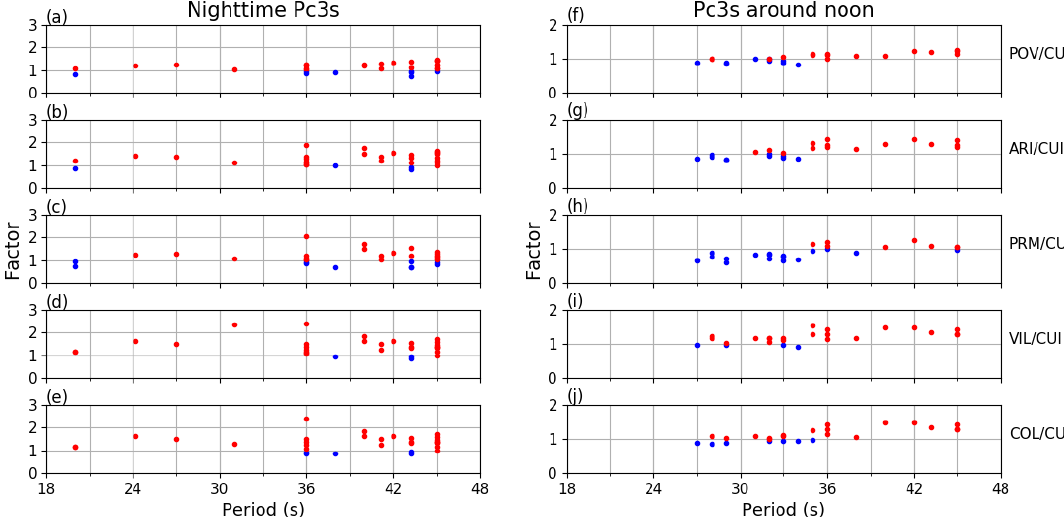
Figure 7. Period dependence of the relative amplitudes of nighttime and noon Pc3 pulsations in equatorial